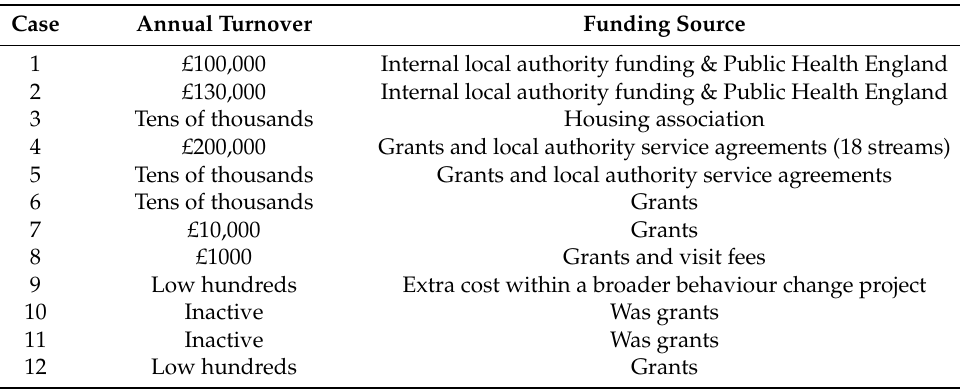
Table 3. Annual turnover and funding